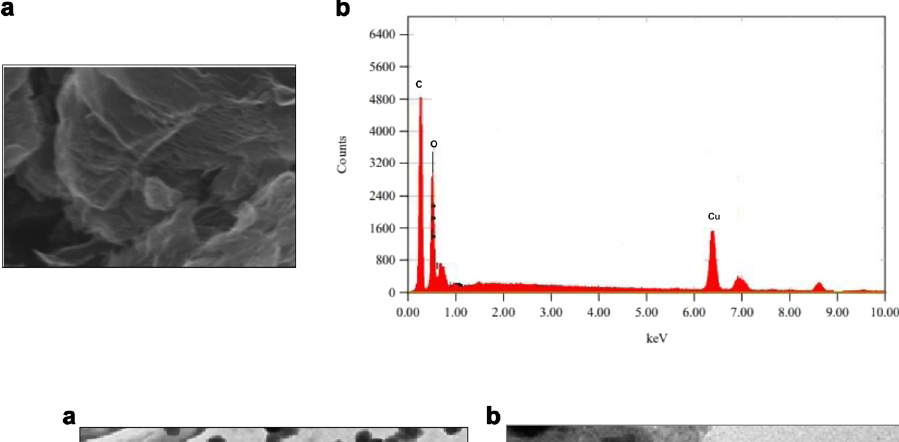
Fig. 4 HR-TEM of CuO/GO nanocomposites indicating the CuO deposits over GO sheets (indicated by arrows)